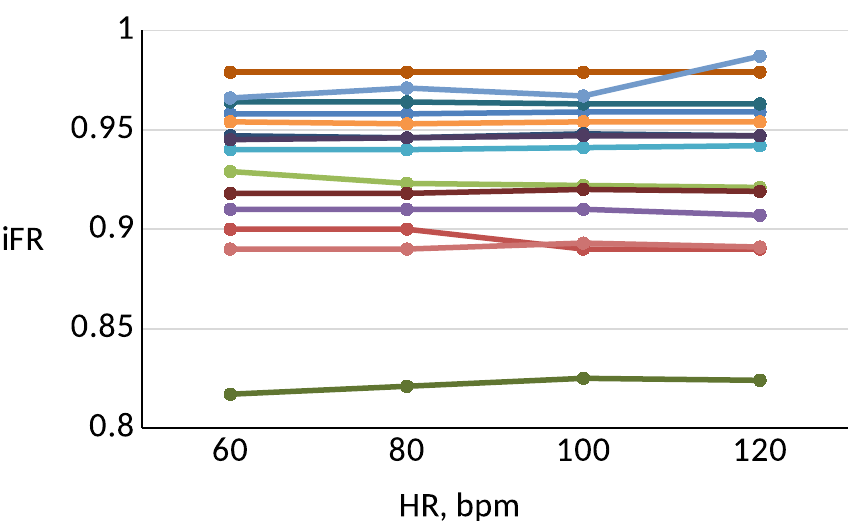
Figure 10. iFR for various heart rates, which was calculated for the full trees by the recursive